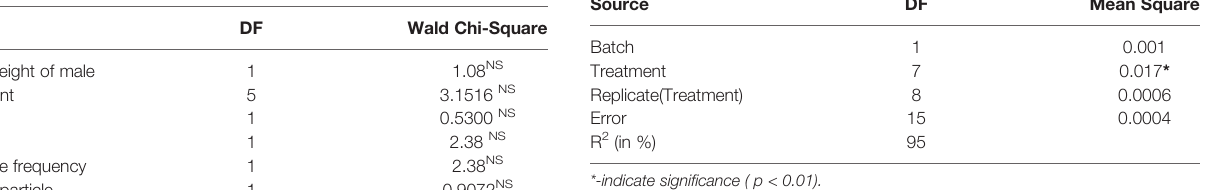
TABLE 2 | ANOVA for factors, body weight of male, treatment, batch, booster, hormone frequency, type of particle, total hormone (Joint test).